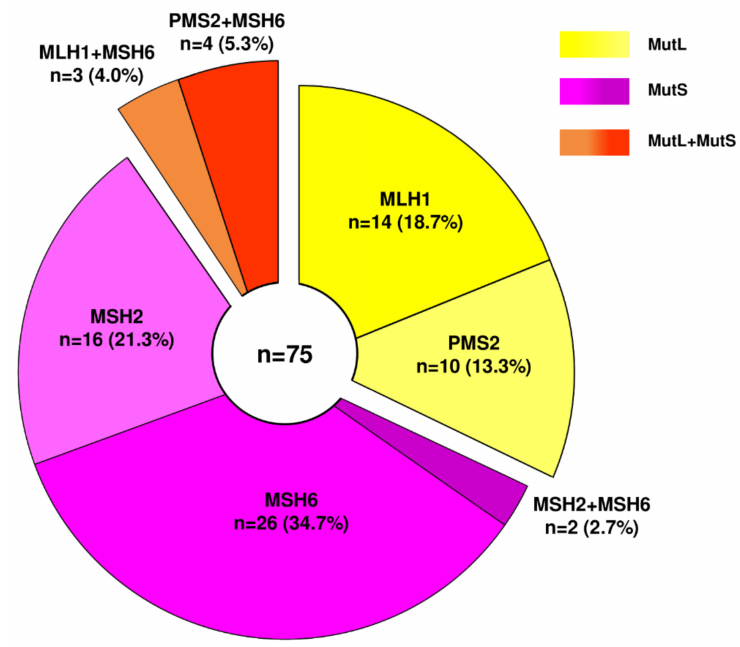
Figure 2. Frequency and patterns of MMR genes alterations across 75 MMR deficient gastroesophageal adenocarcinomas from The Cancer Genome Atlas